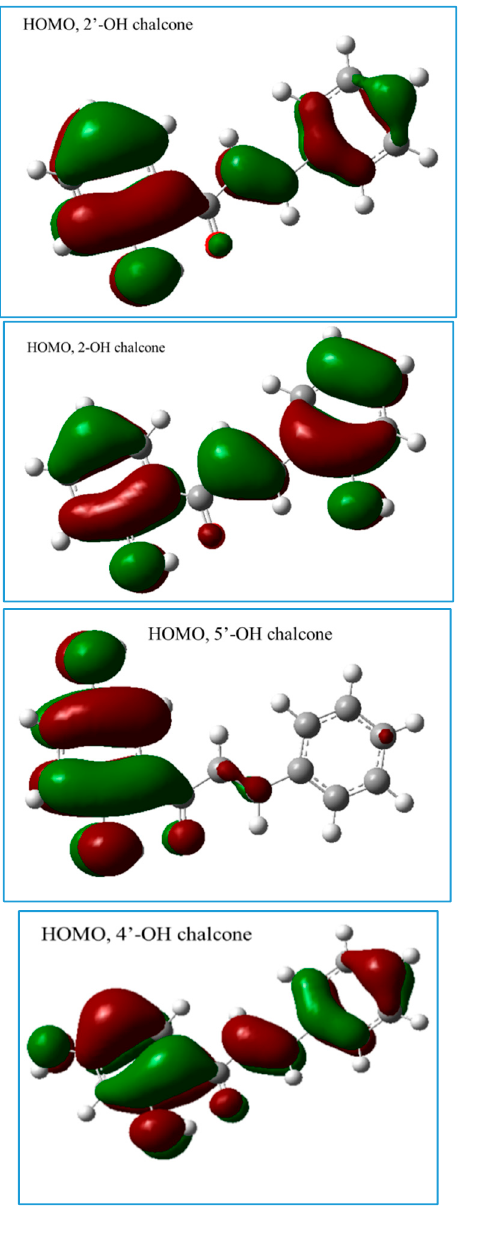
Figure 10. The graphical representation of frontier orbitals of the chalcones derived from F, 2’HF, 6HF and 7HF. (Gaussian 09 and GaussView 5.0.8; Paint/Windows 10; Microsoft Office PowerPoint 2007